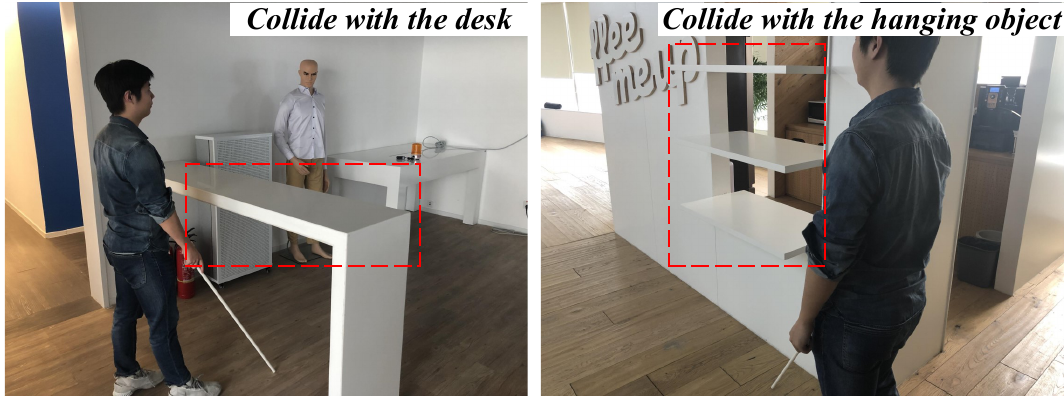
Figure 15. Collisions when the VIP use a white